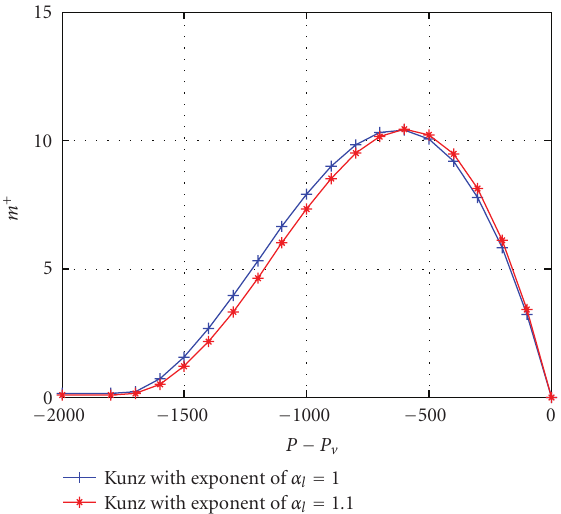
Figure 17: Vaporization term for two values of the exponent of α l .